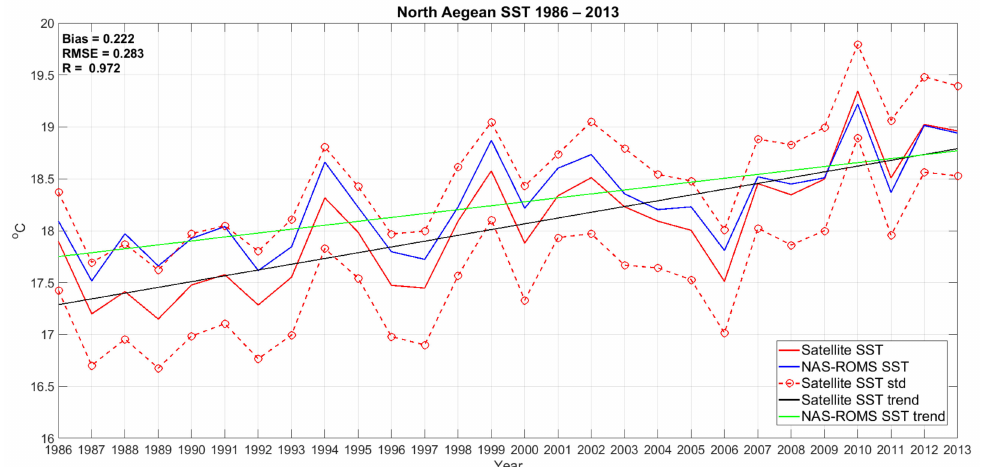
Figure 4. Sea-Surface Temperature interannual variability for the period from 1986 to 2013. Annual mean values from satellite observations and model simulations are presented as red and blue solid lines, respectively. The intervals delimited by one standard deviation around the observed annual mean values are identified by the dashed red line. Overlaid are also the observed and simulated linear trends, as black and green solid lines,